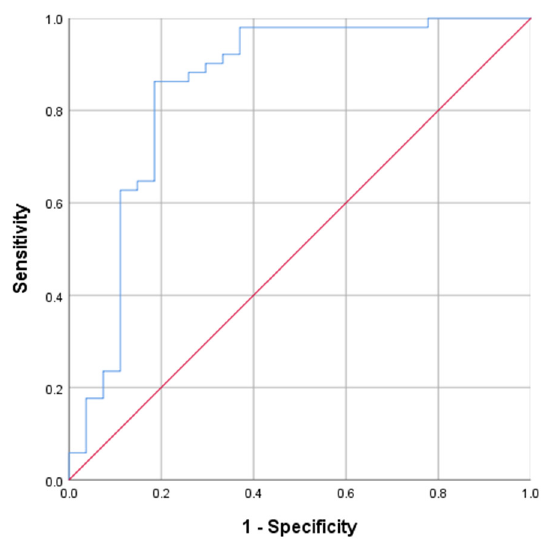
Figure 2. Receiver-operating-characteristic (ROC) curve of serum cortisol suppression in the HDDST for the prognosis of CD remission one year after TSS. The optimal threshold of serum cortisol suppression in the HDDST for predicting the CD remission was 74%; the sensitivity and specificity of the method were 86.3% and 81.5%, respectively ( p < 0.001, AUC = 0.850, 95% CI = 74.4–95.6%).